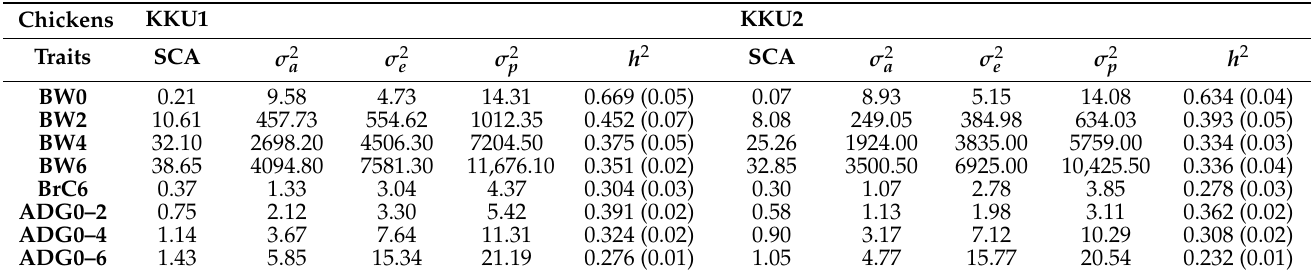
Table 2. Variance components and heritability (standard error) of the crossbred Thai indigenous